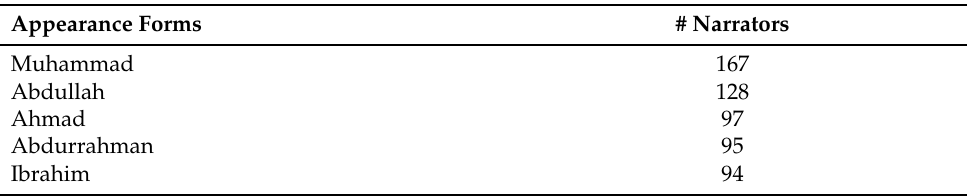
Table 2. Confusing appearance forms that are shared by many narrators. These numbers are obtained by analyzing data from the Khadem Al-haramayn